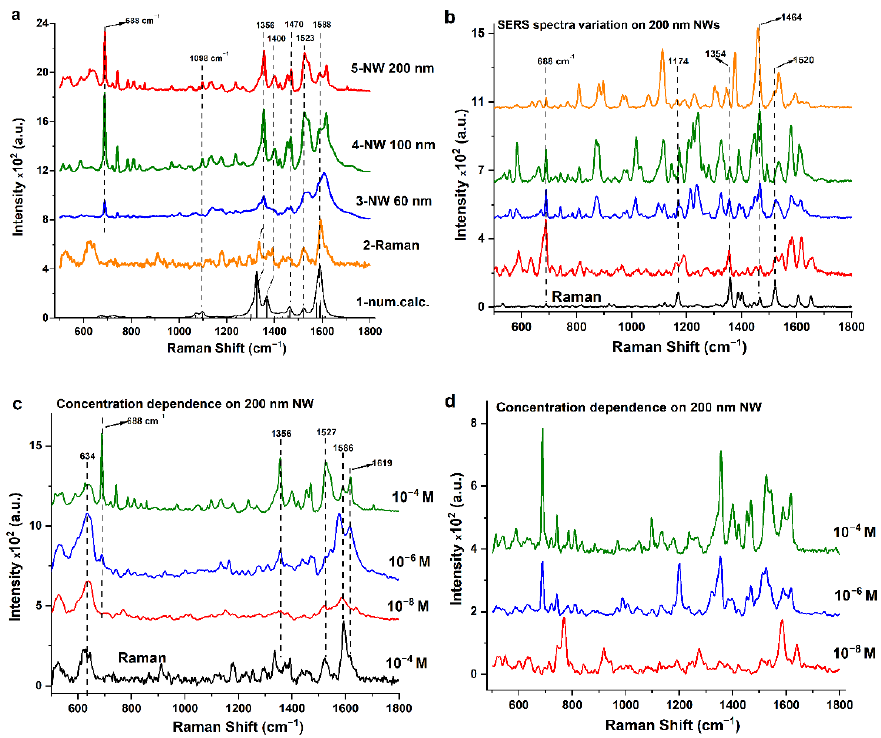
Figure 6. ( a ) Raman spectra of H 2 Pc* (concentration 0.1 mM) as found in quantum-chemical calculations measured on glass substrates, and measured on SERS substrates with different NW diameters (60 nm, 100 nm, 200 nm) obtained by averaging the spectra from all points of SERS substrates. ( b ) Variations of SERS spectra of H 2 Pc* obtained from different points of the SERS substrate with 200 nm NWs. ( c ) Raman spectra of H 2 Pc* with different concentrations as obtained by averaging the spectra from all points of SERS substrates (NW 200 nm) in comparison with an ordinary Raman spectrum from a bulky sample on a glass substrate. ( d ) Raman spectra of H 2 Pc* with different concentrations (NW 200 nm).